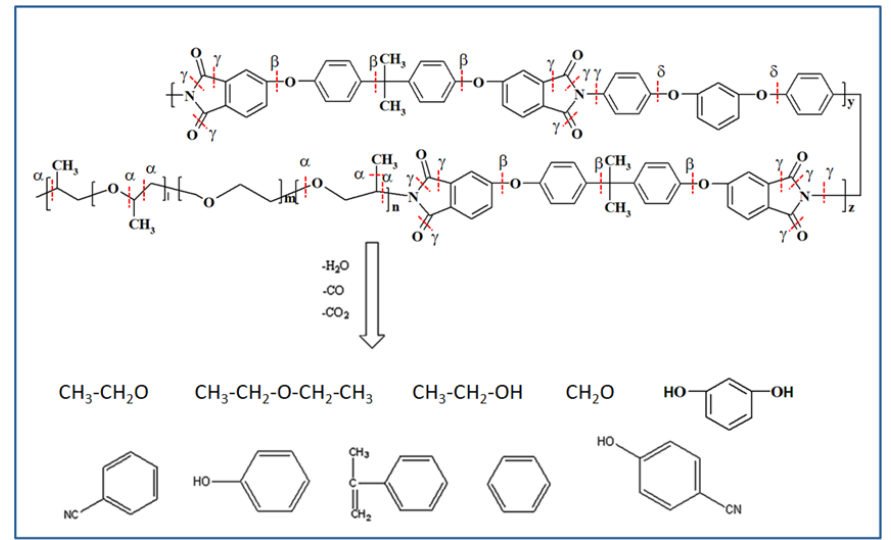
Scheme 2. The proposed thermal degradation mechanism of PEIs (1–3).